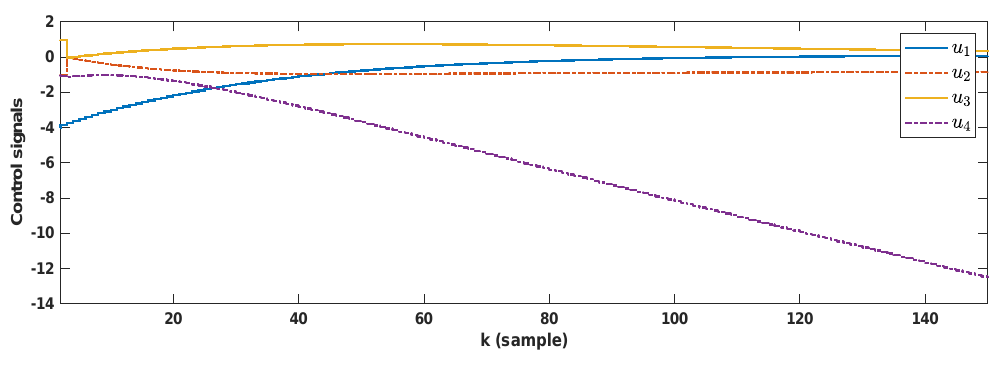
Figure 10. Example 2: Control